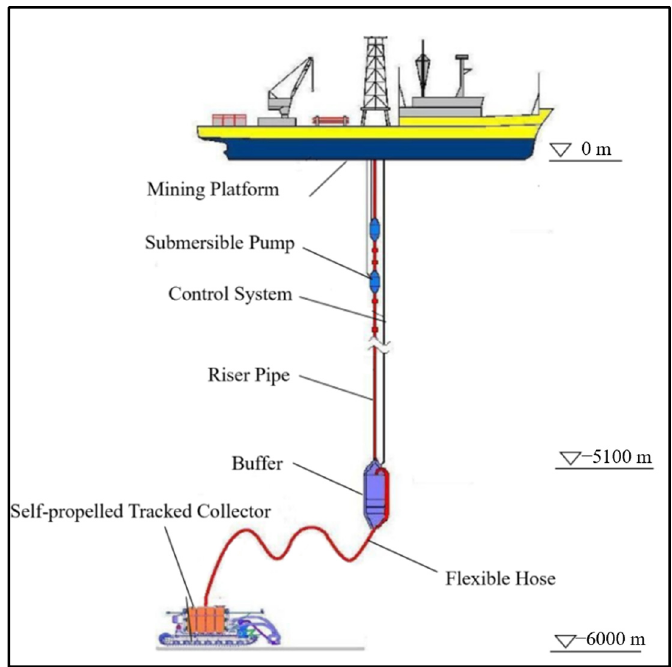
Figure 3. COMRA proposal for a deep-sea nodule commercial mining system